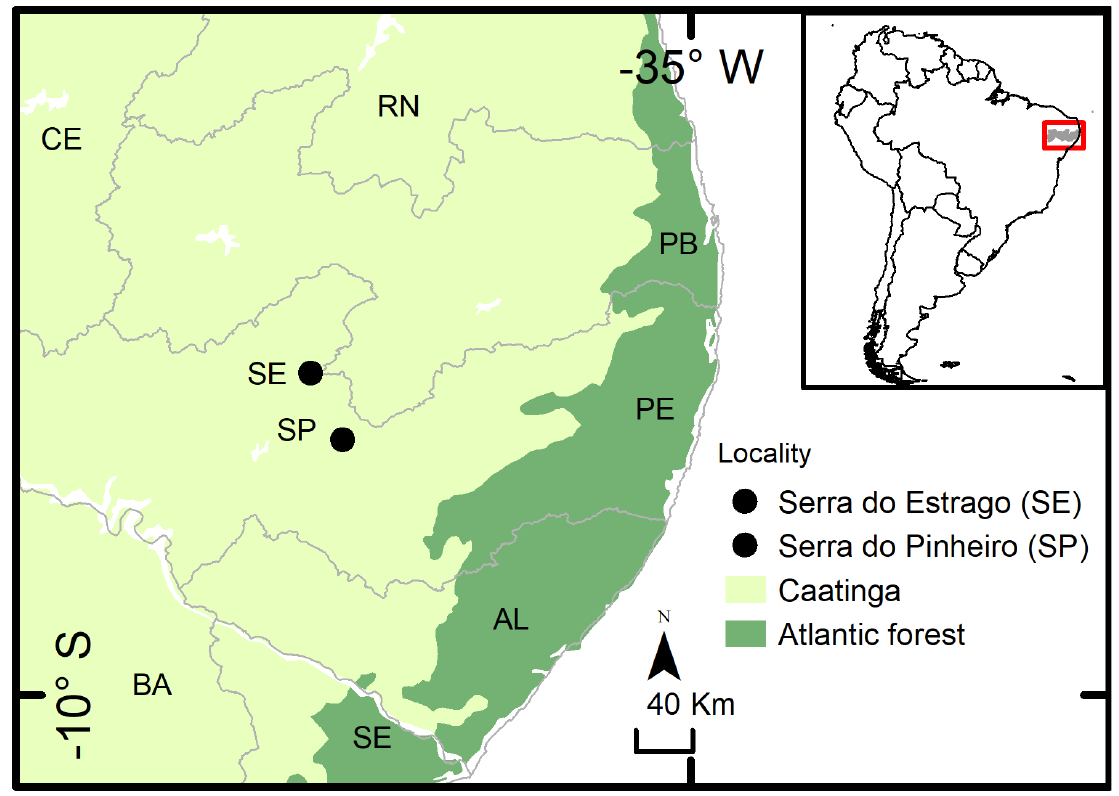
Figure 1. Location of the S. libidinosus populations sampled in the present study. The populations live in fragments of Caatinga Biome, in the state of Pernambuco, North-eastern Brazil. Serra do Pinheiro (SP): -37.20 w, -8.38 s, Serra do Estrago (SE): -37.40 w, -7.96 s. (States: CE-Ceará; RN- Rios Grande do Norte; PB- Paraíba; PE- Pernambuco; AL - Alagoas; SE- Sérgio; BA-